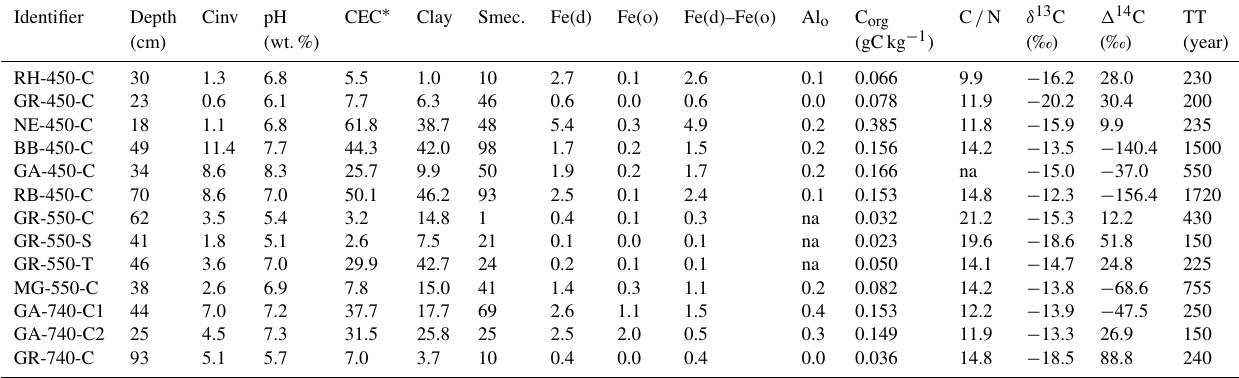
Table 5. Profile-averaged (excluding BC / C horizons) properties for the soils sampled in this study. Averages for C and C isotopes are calculated from bulk values. C inventory (C inv ) is the sum for the profile in kgCm − 2 . All averages are mass-weighted, except C isotopes which are weighted by the mass of C in each horizon. Smectite content (Smec.) is estimated from multiplying the fraction of total mass in the clay-sized XRD by the %Clay (denoted in the table as Clay and expressed as percent of total mass) by the percent of the clay-sized XRD identified as Smectite (Smec.; Table 2). Profile-averaged values for ditionite citrate extracted iron (Fe(d)) and oxalate extractable iron Fe(o) and aluminum (Al(o)), as well as their difference, a measure of Fe oxyhydroxides in bulk soil, are all expressed as weight% as in mass Fe per 100g of soil.